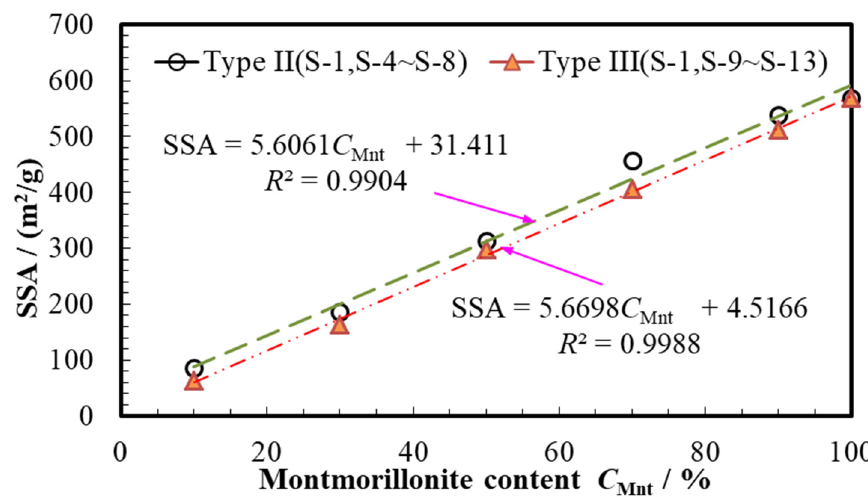
Figure 3. Relationship between SSA and C Mnt of soils.